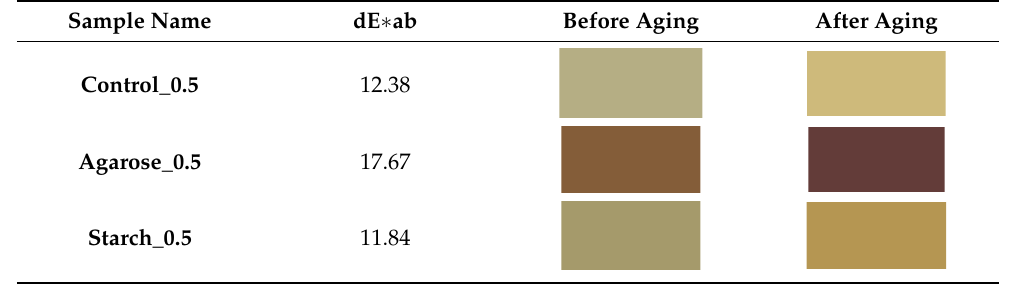
( B ) Figure 10. Contact angles of water ( A ) and diiodomethane ( B ) on the surfaces of selected blends (0.5M NaOH) after thermo-oxidative aging. Figure 10 shows the results of the contact angles for samples subjected to thermo- oxidative aging for 7 days. The contact angles for the polar liquid (distilled water) in- creased for all mixtures after aging, ranging from 114° to 135°. This indicates a change in the structure and formation of more hydrogen bonds due to the presence of free radicals in the matrix. The greatest change in the contact angle was observed for the sample with